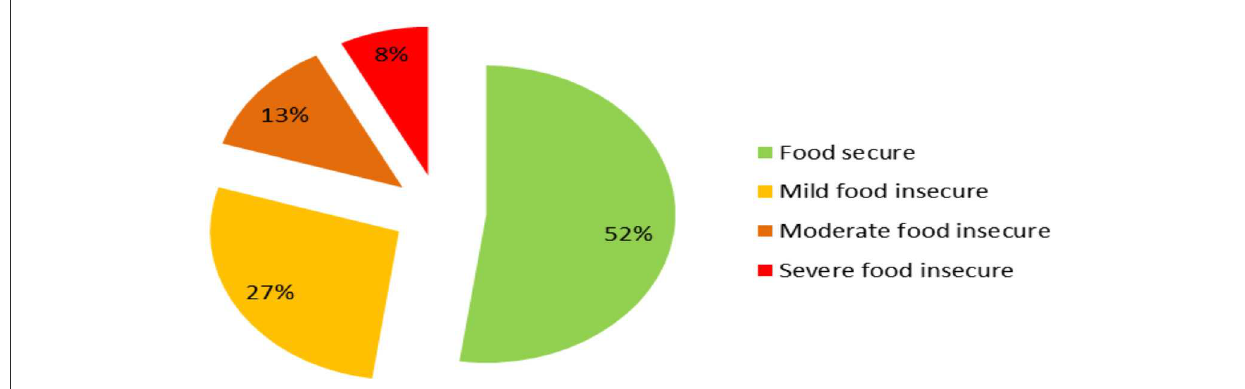
FIGURE1 Level of household food insecurity in the selected sample.